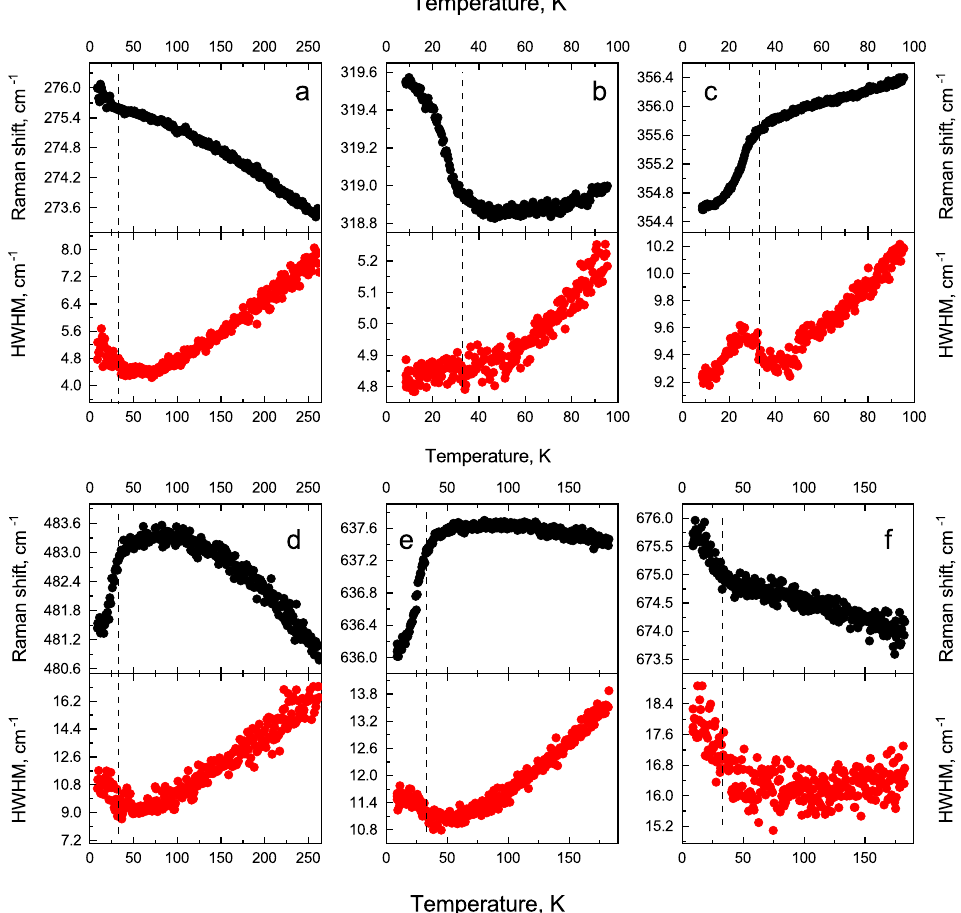
Figure 4. ( a – f ) Temperature dependencies of Raman line positions (black color) and halfwidths (red color). The dashed line denotes the temperature of structural phase transition 33